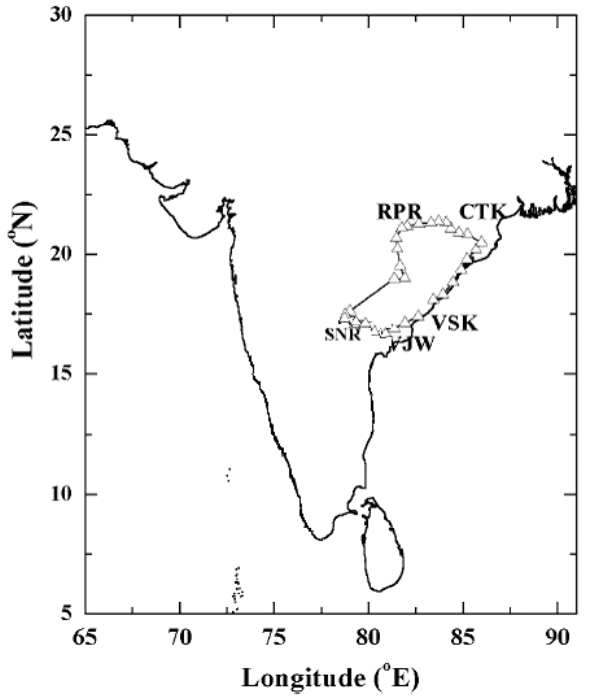
Fig. 1. Route taken by the Andhra University team in the ISRO- GBP Land Campaign. The triangles represent the locations of ob- servation. The legends show major cities: VJW: Vijayawada, VSK: Visakhapatnam, CTK: Cuttack, RPR: Raipur, SNR, Shadnagar near Hyderabad.